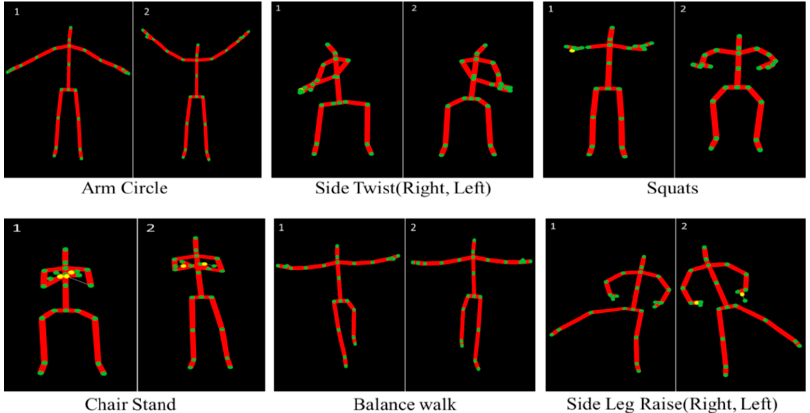
Figure 1. The extracted skeleton of the human body while performing different activities . them in CSV files. We collected a dataset from 20 different participants and every partici- pant perform an activity for 10 s. There are 200 samples of each activity where every par- ticipant performs each activity for 10 times (120 samples per participant). The human skel- eton joints are extracted and stored in the following order shown in Figure 2. Each activi- ties files are combined and labeled with their class as shown in Table 1. After labeling all activities data, all these files are further combined in a single training file. Table 1 shows the detailed description of the individuals and activities during data collection. Figure 2. Different skeleton joints of the human body are extracted through sensors. Table 1. Shows the dataset collection and activities details. Labels